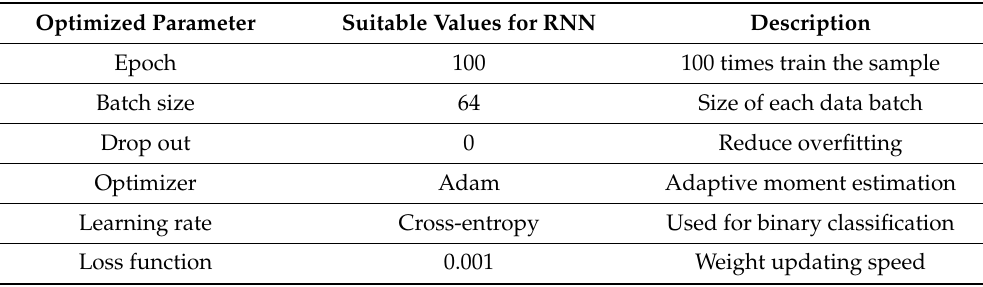
Table 2. RNN model parameters and importance.